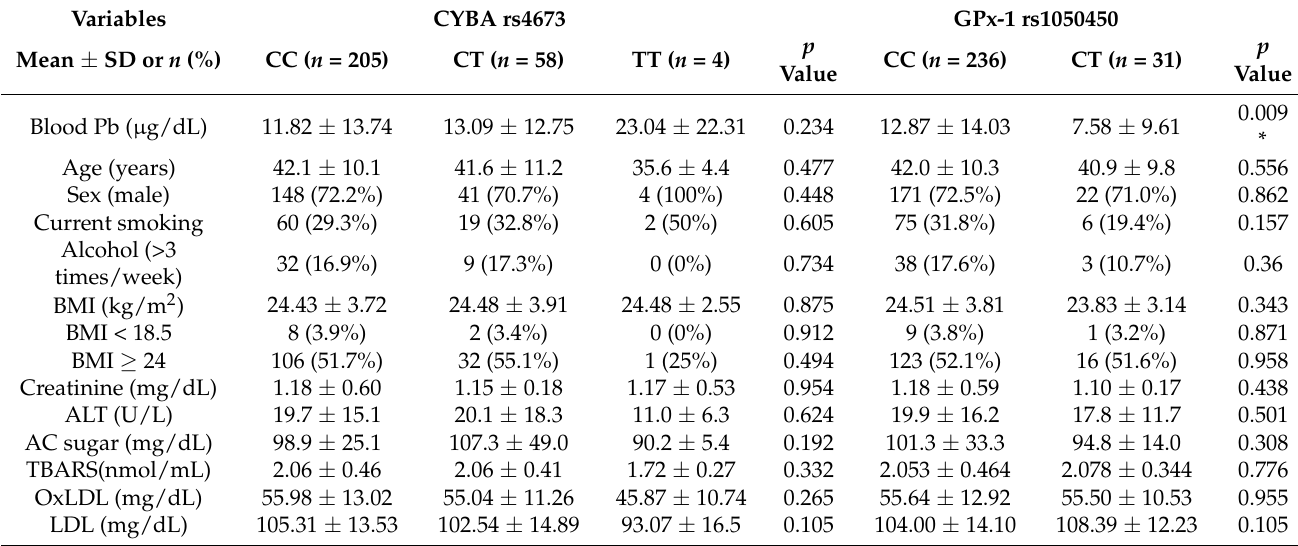
Table 2. Descriptive characteristics among the different types of CYBA rs4673 and GPx-1 rs1050450 SNPs.